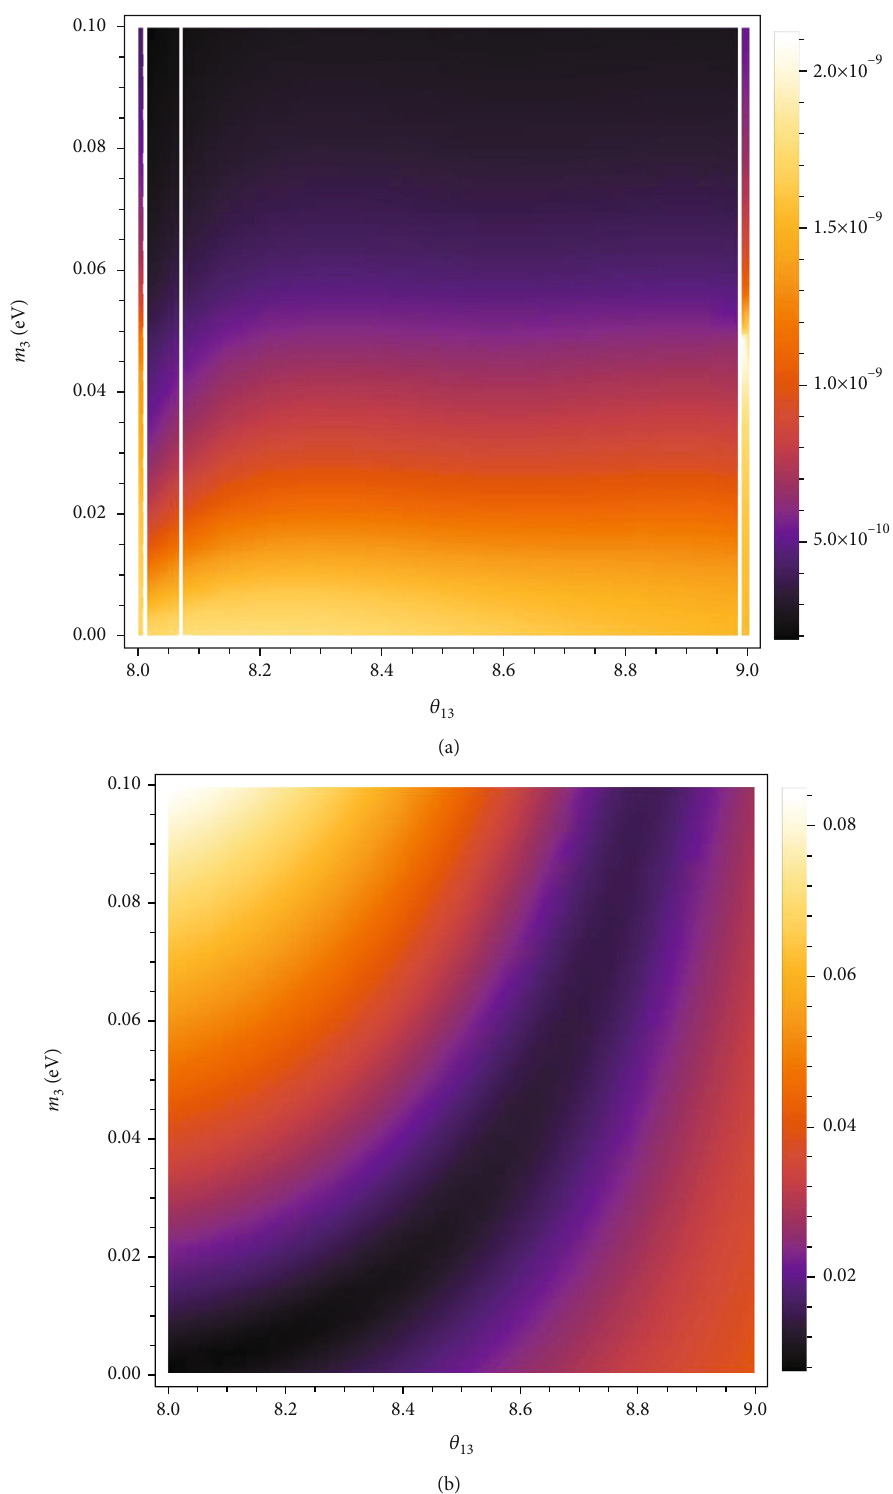
Figure 17: Predictions in the broken μ − τ symmetry model for inverted ordering. (a) The density plot of predicted favoured values of the ð m Þ plane for the best fi t values of δ , θ 3 13 asymmetry of the Universe) as a result of contribution of the type I seesaw mechanism to neutrino mass matrix. Similarly, (b) shows the predicted two-dimensional space of ð m